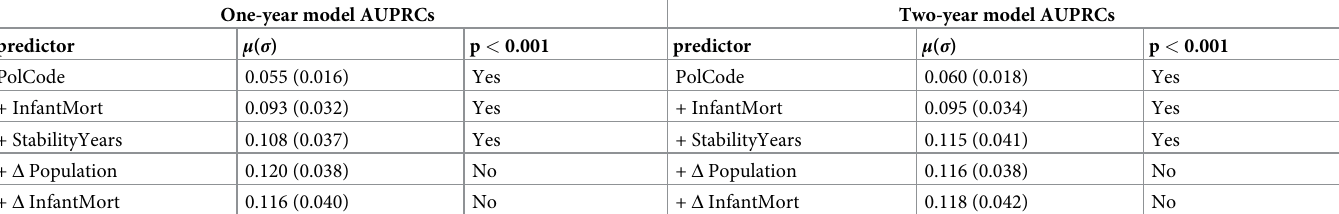
Table 2. Comparison of AUPRCs. μ and σ of AUPRCs generated from models trained on 200 simulated data sets for one- and two-year prediction periods. Each test set comprises a random selection of ten reference years drawn from the period 1975—1999 inclusive.